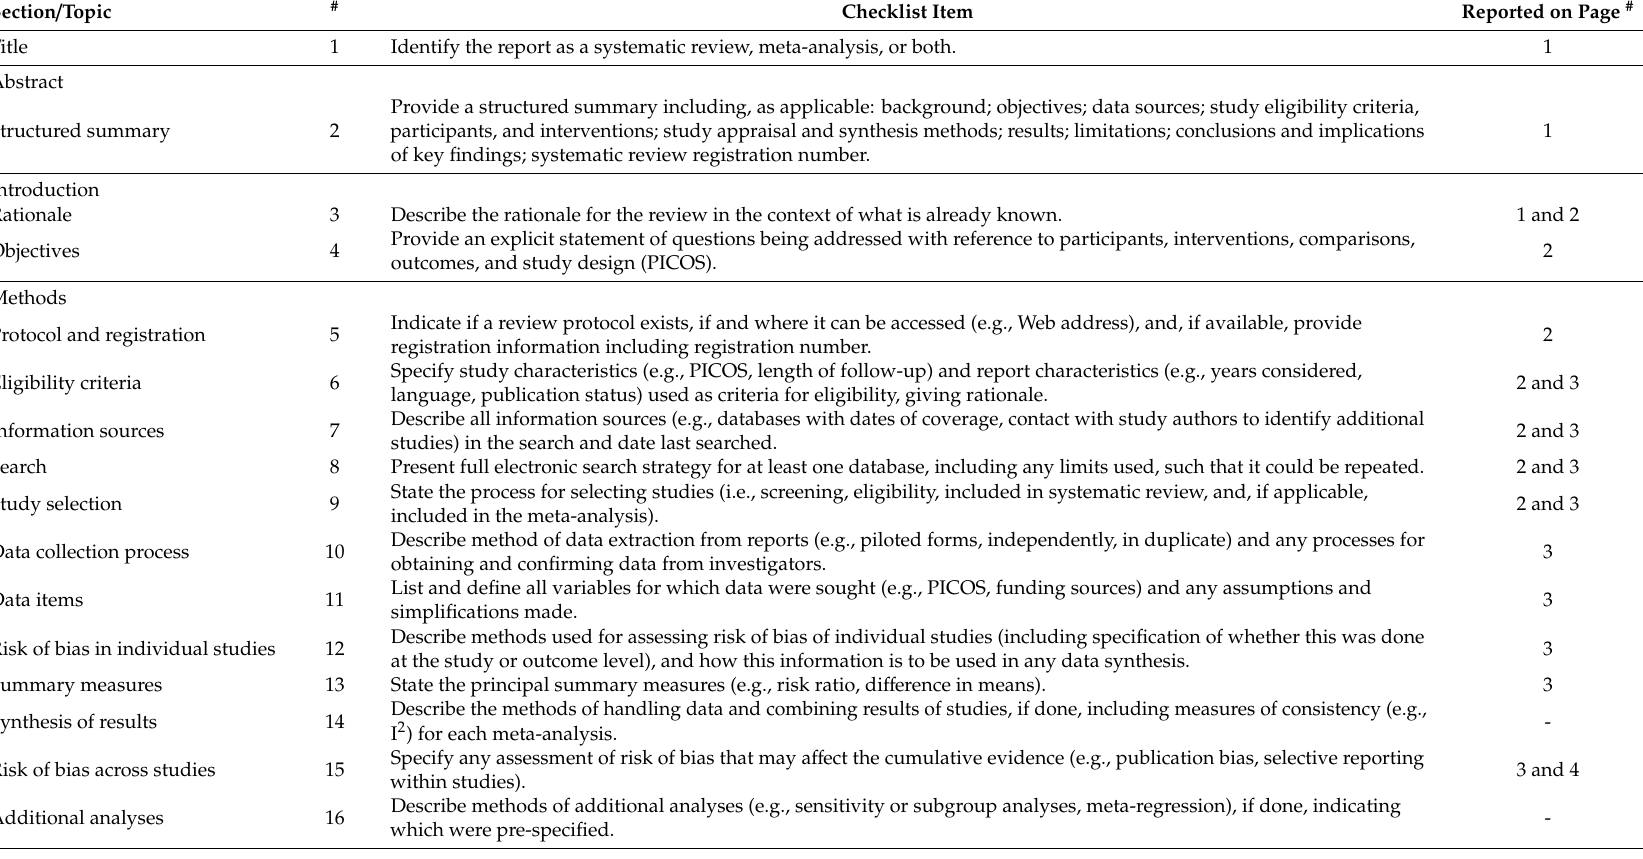
Table A1. PRISMA